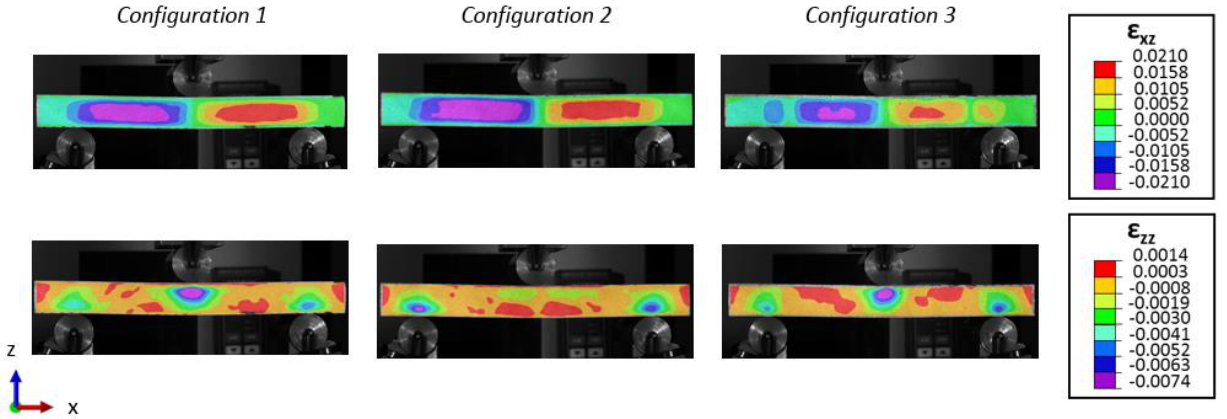
Figure 9. Comparison between the ε xz and ε zz strain contours of the three specimen configurations at an applied displacement of 1.2